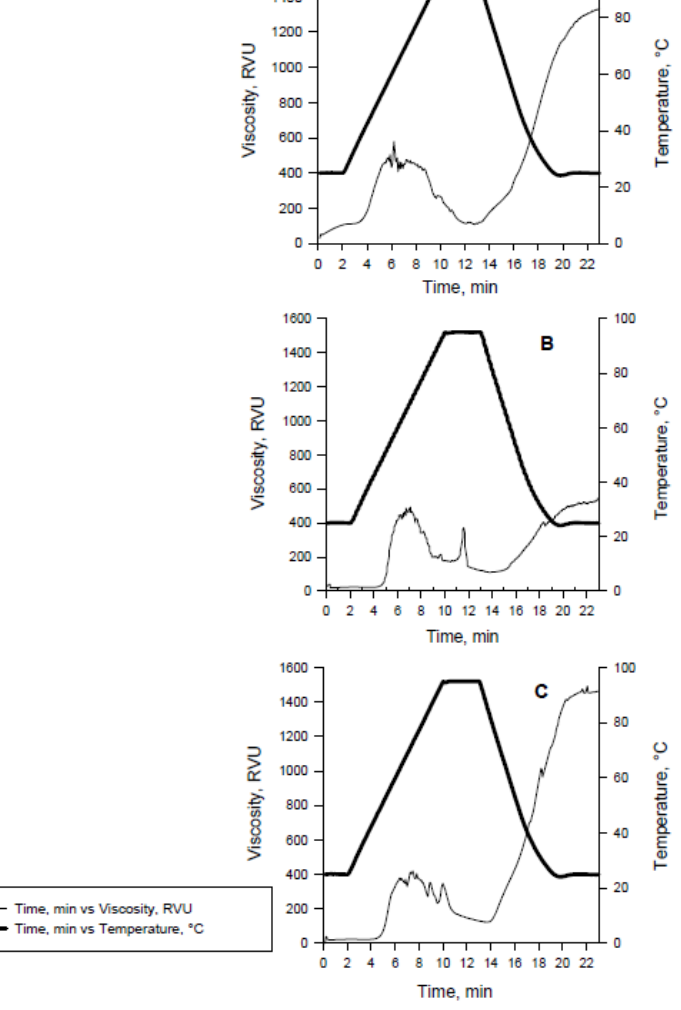
Figure 2. Rapid-visco analyzer (RVA) curve of the ( A ) high shear; ( B ) medium shear; ( C ) low shear food (average of three replicates each). Cooked starch AUC was considered from min 0.4–6.0, raw starch AUC was considered from min 6.1–14.0 min, and high Mw starch (setback viscosity) from 14.1–23 min.